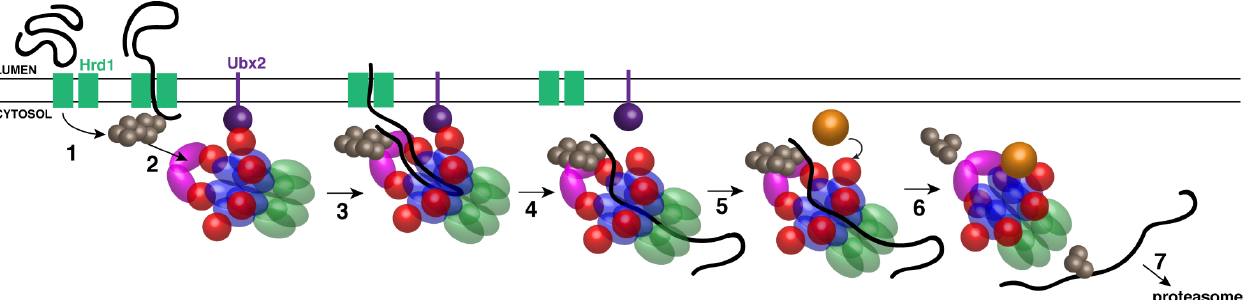
Figure 4. Model for Cdc48 function in endoplasmic reticulum–associated protein degradation. In step 1, a segment of a misfolded luminal substrate is moved into the cytosol and polyubiquitinated by Hrd1. In step 2, the Cdc48 complex is bound to the cytosolic face of the endoplasmic reticulum via an interaction of its N domain with Ubx2. The complex recognizes the polyubiquitin chain via Ufd1/Npl4 (UN). In step 3, Cdc48 uses ATP hydrolysis in the D2 domains to extract the substrate from the membrane, translocating the polypeptide through its central pore. In step 4, Cdc48 completes translocation and eventually diffuses away from Ubx2, together with the bound substrate. In step 5, a deubiquitinase (DUB) such as Otu1 binds to the newly vacant N domain. In step 6, the D1 domains hydrolyze ATP, moving the N domains to the “down conformation” and allowing trimming of the ubiquitin chain. The oligoubiquitinated substrate then is released from the trans side of the pore. In step 7, the substrate is transferred to downstream factors, eventually arriving at the